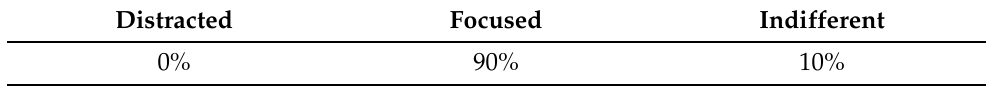
Table 3. Answers to the user experience